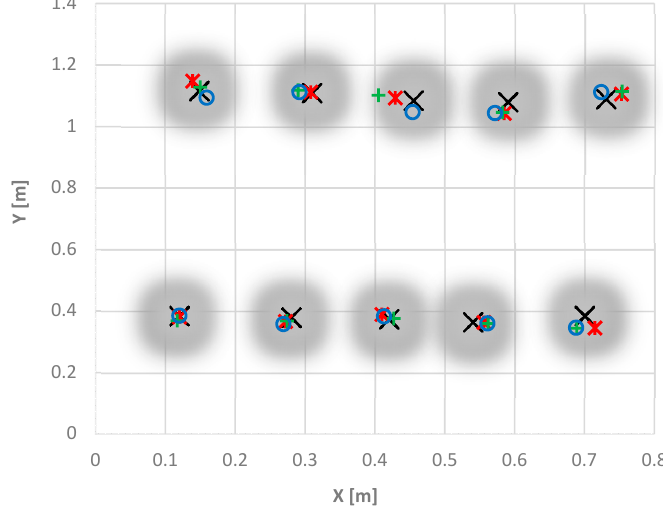
Figure 5. Estimated plant poses in x and y —with the ground truth (x) and the results for the three scans (*, o, +).